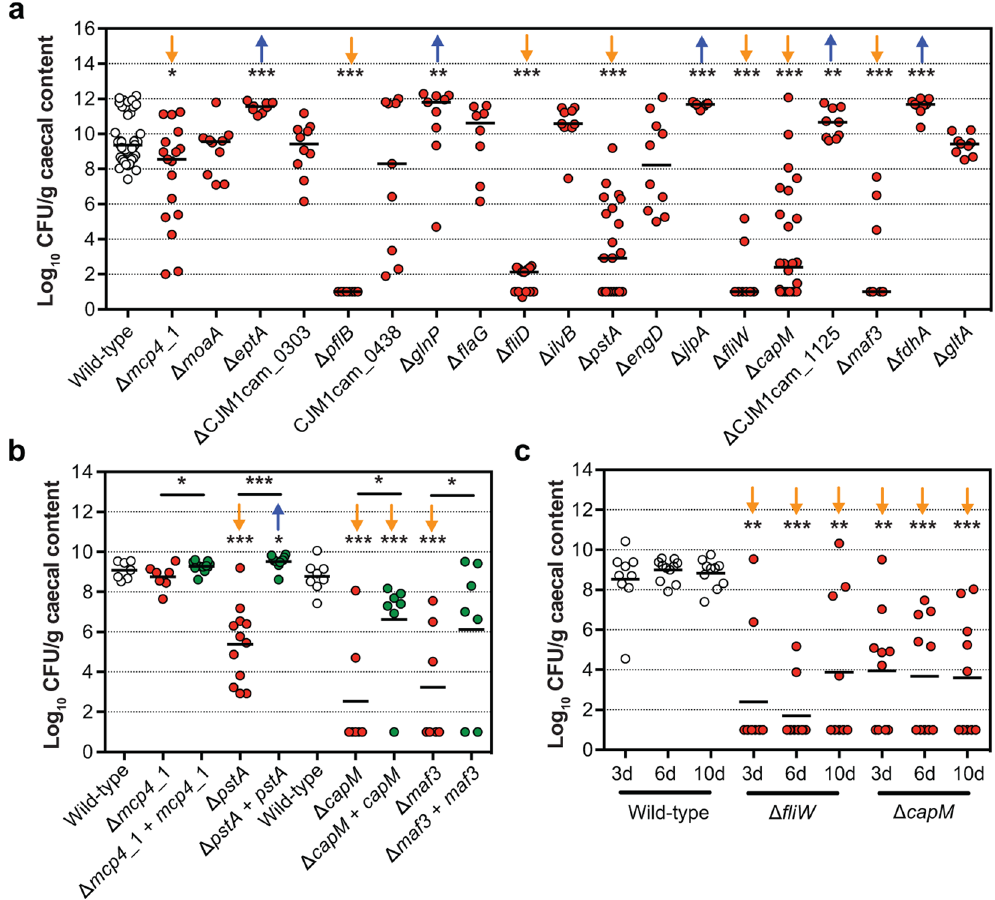
Figure 3. Validation of chicken colonisation Tn mutant library screen. ( a ) Colonisation levels of C . jejuni M1cam gene deletion mutants 6 d pi. ( n ≥ 7) ( b ) Colonisation of gene deletion mutants and complemented gene deletion mutants ( n ≥ 7). ( c ) Colonisation kinetics of C . jejuni M1cam wild-type and defined mutants in fliW and capM ( n ≥ 9). Chickens being colonised vs not colonised were 2/8, 2/8 and 3/6 for the fliW mutant and 4/5, 4/6 and 5/5 for the capM mutant at day 3, 6 and 10 p.i., respectively. Statistical significance was analysed using a Mann-Whitney test with * P < 0.05, ** P < 0.01 and *** P < 0.001. The orange arrows represent an attenuated phenotype while the blue arrows represent an enriched chicken colonisation